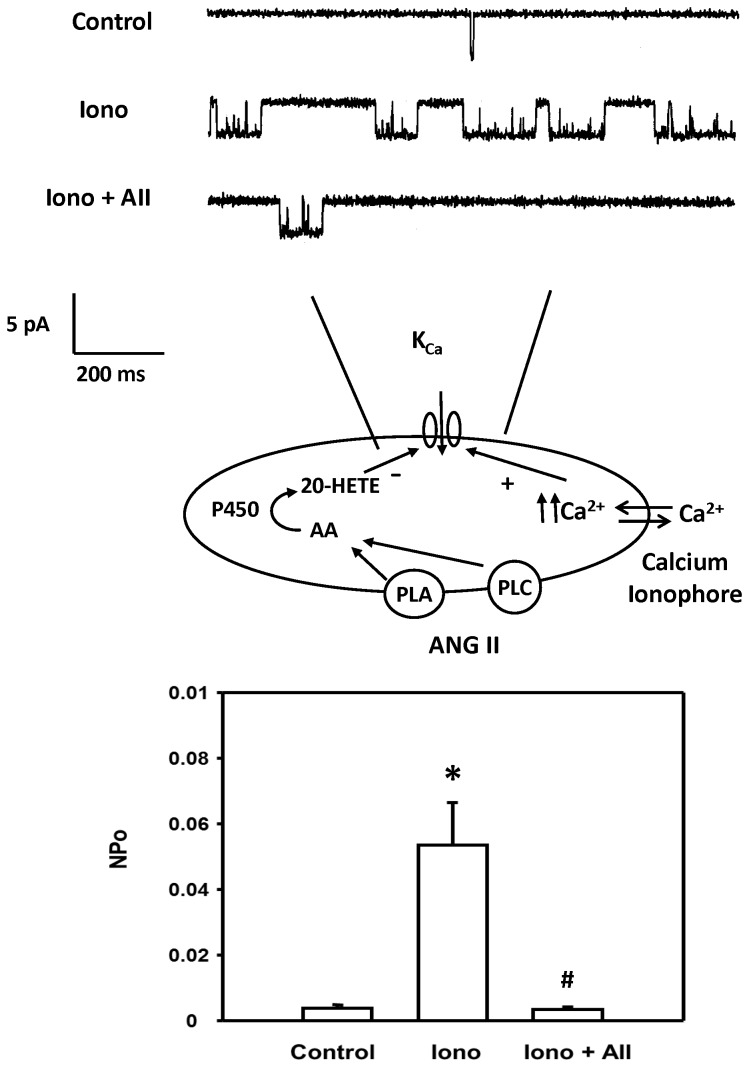
Effect of ANG II on KCa channel activity in renal VSM cells with high [Ca2+]i.The upper panel presents a representative current recording of the effects of ANG II on KCa channel activity recorded using cell-attached patches on renal arteriolar VSM cells. The middle panel summarizes the patch clamp recording mode. KCa channel currents were recorded with 140 mM KCl in the pipette at the resting membrane potential (pipette potential = 0 mV) and the cells were bathed in normal physiological salt solution in the presence of ionomycin. The lower panel summarizes the effects of ionomycin and subsequent addition of ANG II on the KCa channel activity. * indicates the significant difference from the control value. # indicates a significant difference from the corresponding value recorded in the presence of ionomycin.